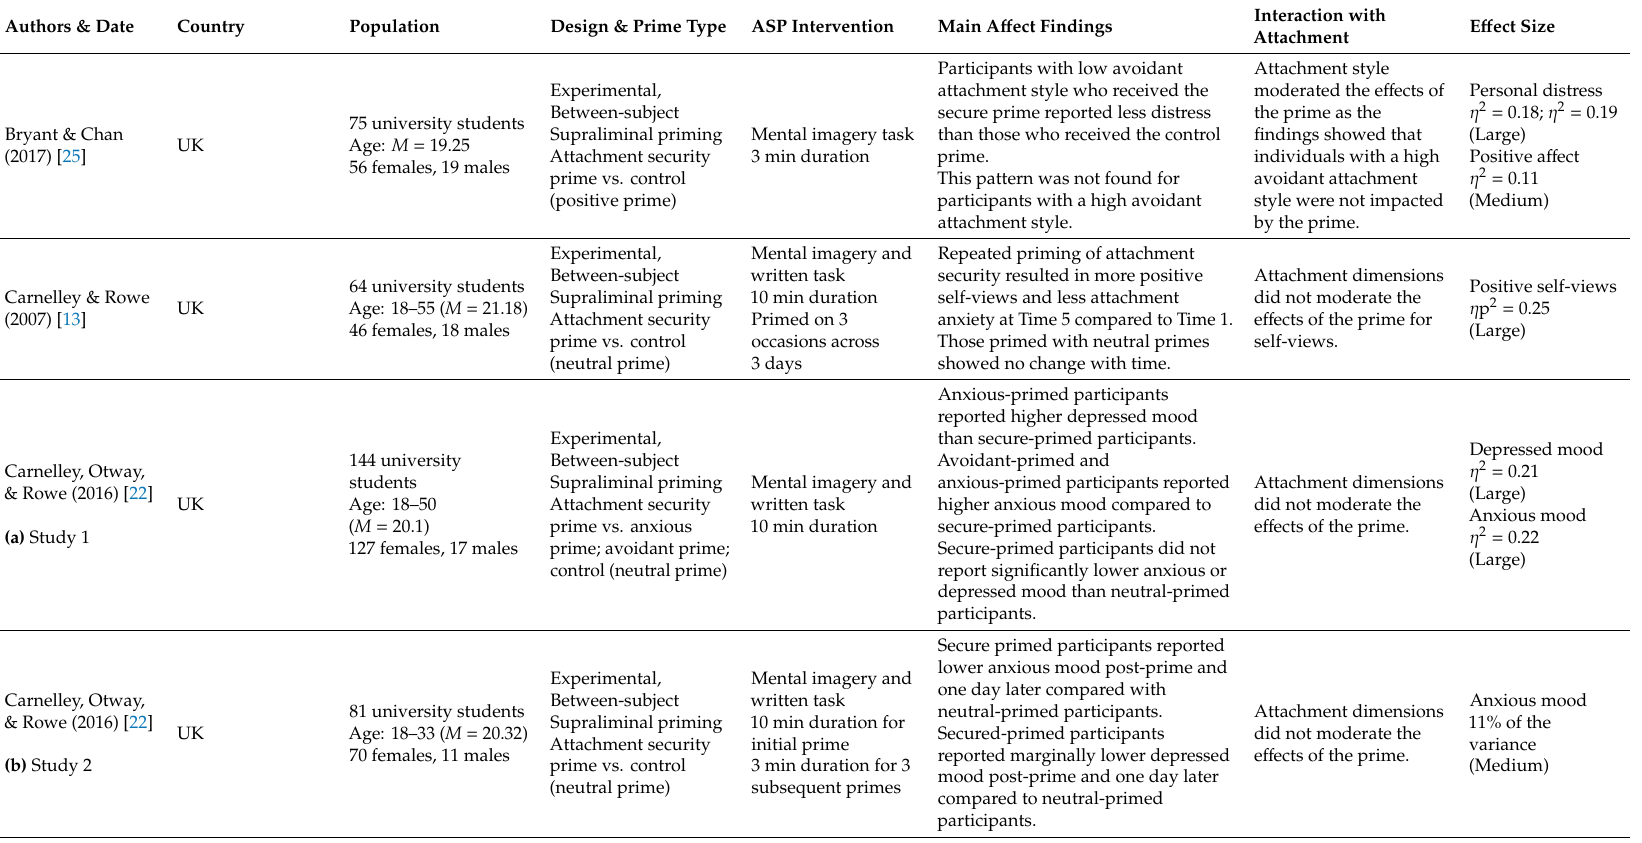
Table 1. Summary of Studies Included in the Systematic